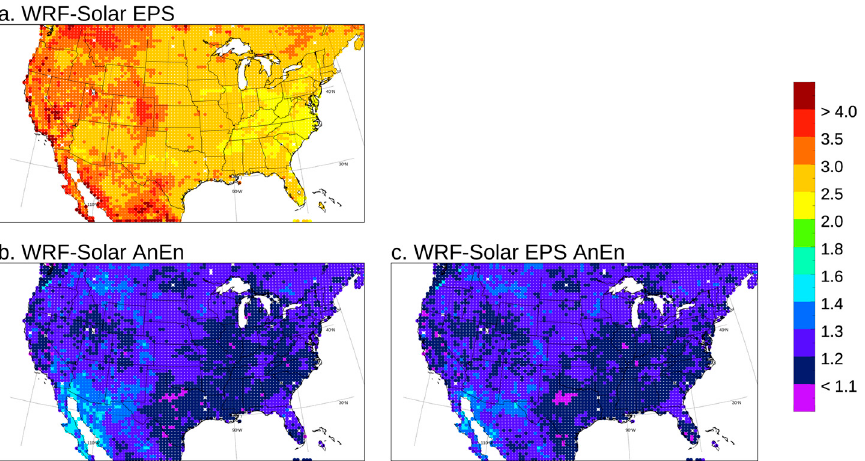
Figure 6. RMSE/spread ratio computed for all the grid points pooling the forecast lead times from +24 to +48 h and forecast runs for 2018 together.